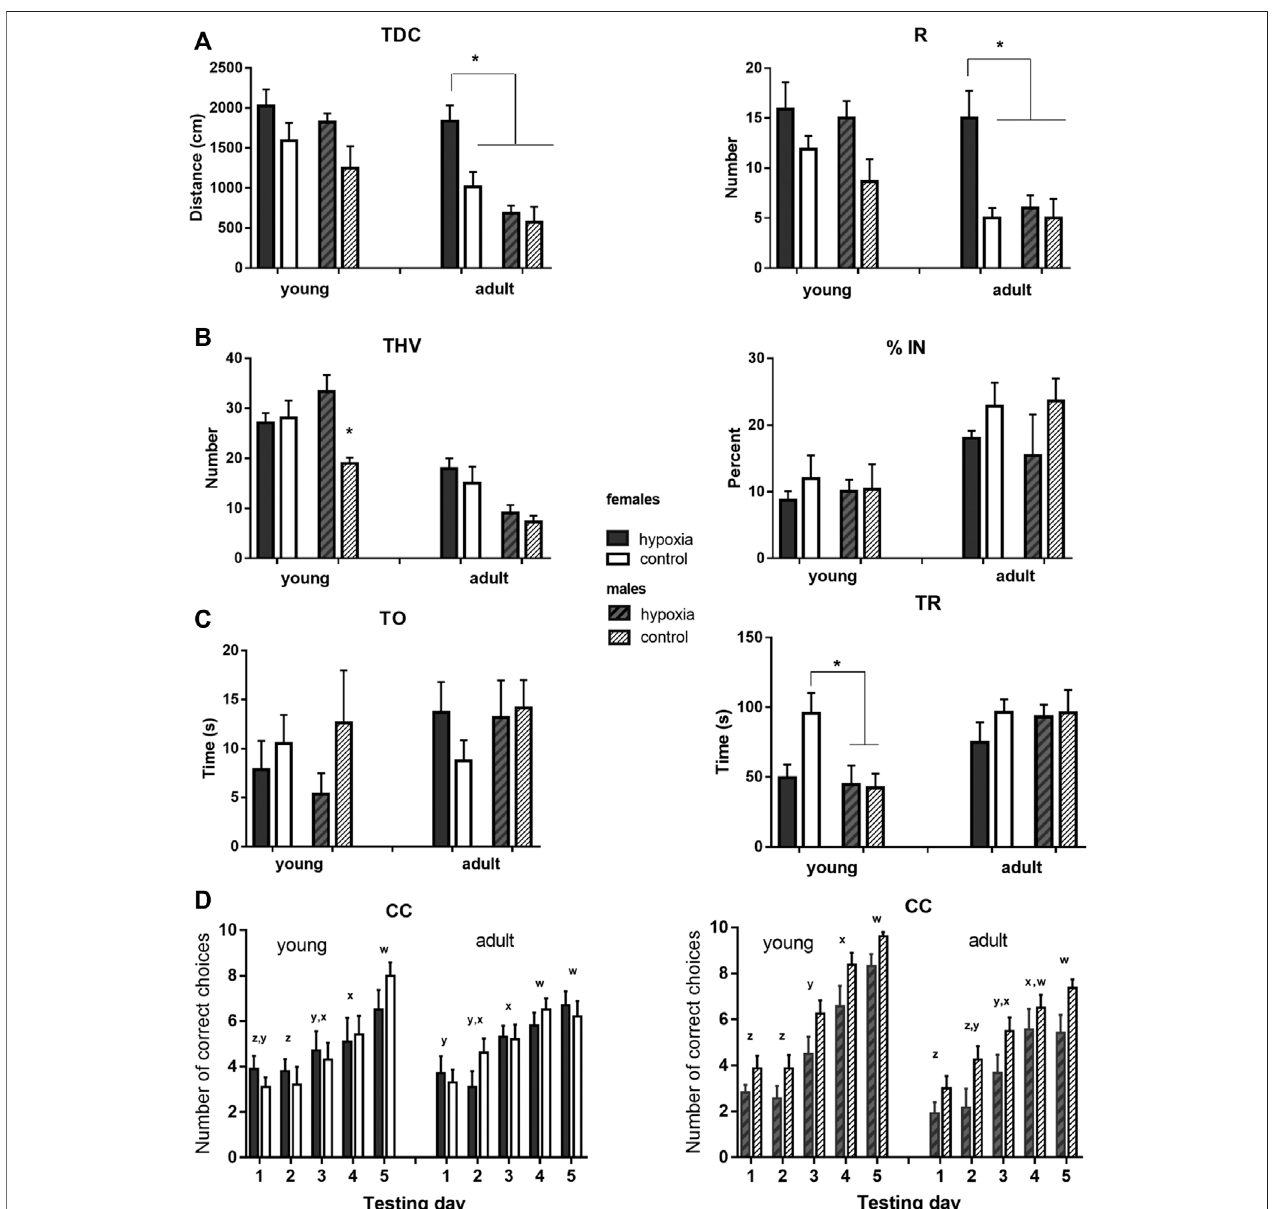
FIGURE4| Resultsofthebehavioraltestinginyoungandmatureanimalsdisplayalteredbehaviorandcognitioninjuvenileandadultrats.Theratswereexposedto a battery of behavioral tests at juvenile (adolescent) (P33-P41) and adult (P83-P91) ages, to examine whether any behavioral and cognitive differences were still present orhadnewlyappearedinadulthood. (A) Locomotoractivitywasmeasuredasthetotaldistancecovered(TDC)andthenumberofrearingtimes(R)inanopen fi eld.Two- way ANOVA revealed: for TDC, a signi fi cant in fl uence of hypoxia in juveniles and of hypoxia, sex, and hypoxia-sex interaction in the adults; for R, there was a signi fi cant in fl uence of hypoxia in juveniles and a signi fi cant in fl uence of hypoxia and sex, with the indicative in fl uence of hypoxia-sex interaction in the adults. (B) Exploratorybehaviorwasmeasuredasthetotalnumberofvisitedholes(THV),andanxiety-likebehaviorwasmeasuredasthepercentageofvisitedinnerholes(%IN)ina hole-board. Two-way ANOVA revealed: for THV, a signi fi cant in fl uence of hypoxia and hypoxia-sex interaction in juveniles and a signi fi cant impact of sex in adults; for % IN, no signi fi cant in fl uences. (C) Social behavior was measured as time spent exploring an object (TO) and time spent exploring a rat (TR) in a social choice apparatus. Two-wayANOVArevealedforTO,nosigni fi cantin fl uences;forTR,asigni fi cantin fl uenceofsex,andhypoxiaxsexinteraction,onlyinjuveniles. (D) Learningabilitieswere measured in a T-maze separately for males and females, and as the number of correct choices (CC) in sessions of ten trials during fi ve consecutive days. Repeated measure two-way ANOVA revealed: for males, a signi fi cant in fl uence of hypoxia and time, in juveniles, and an indicative in fl uence of hypoxia and a signi fi cant effect of time, in adults; for females, the analysis showed a signi fi cant in fl uence of time, in both juveniles and adults. Results are shown as mean ± standard error of the mean (SEM);Tukey ’ shonestlysigni fi cance post-hoctest wasperformedafter establishingasigni fi cant/indicativehypoxia-sexinteractionin fl uenceand valuesthatsigni fi cantly differaremarkedwithan* (A – C) .Lettersx-zareindicatorsofsigni fi cantdifferences(differentletters)orthelackofsigni fi cantdifference(sameletters)inthemeannumber of correct choices among different testing days as revealed by Tukey ’ s honestly signi fi cance post-hoc test (D) .